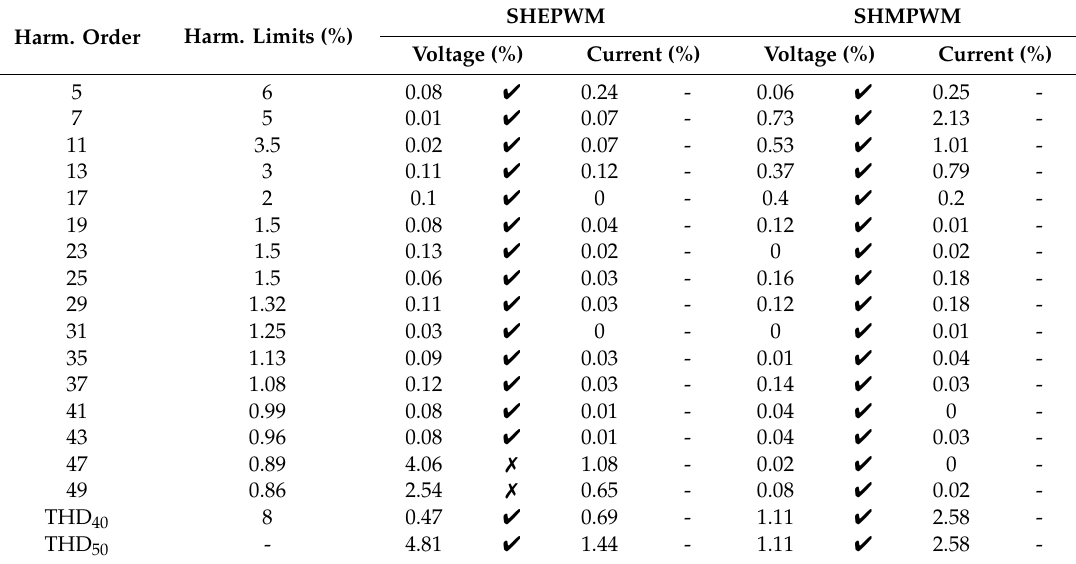
Table 5. Simulation results of SHEPWM and SHMPWM at grid side. Harm.